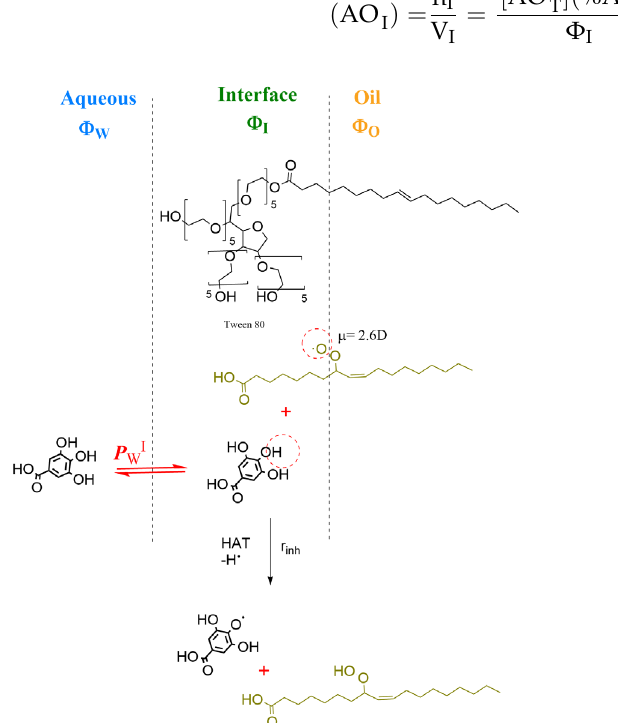
Figure 2. Two-dimensional representation of an emulsion droplet showing the aqueous, interfacial and oil regions and the chemical structures of the surfactant Tween 80, the antioxidant gallic acid GA and that of a peroxyl radical. The orientation of the reactants is illustrative. GA is oil-insoluble and only distributes itself between the aqueous and interfacial regions. The inhibition reaction (HAT mechanism) of GA with the peroxyl radicals mainly takes place in the interfacial region of the emulsion and through the HAT mechanism [42].